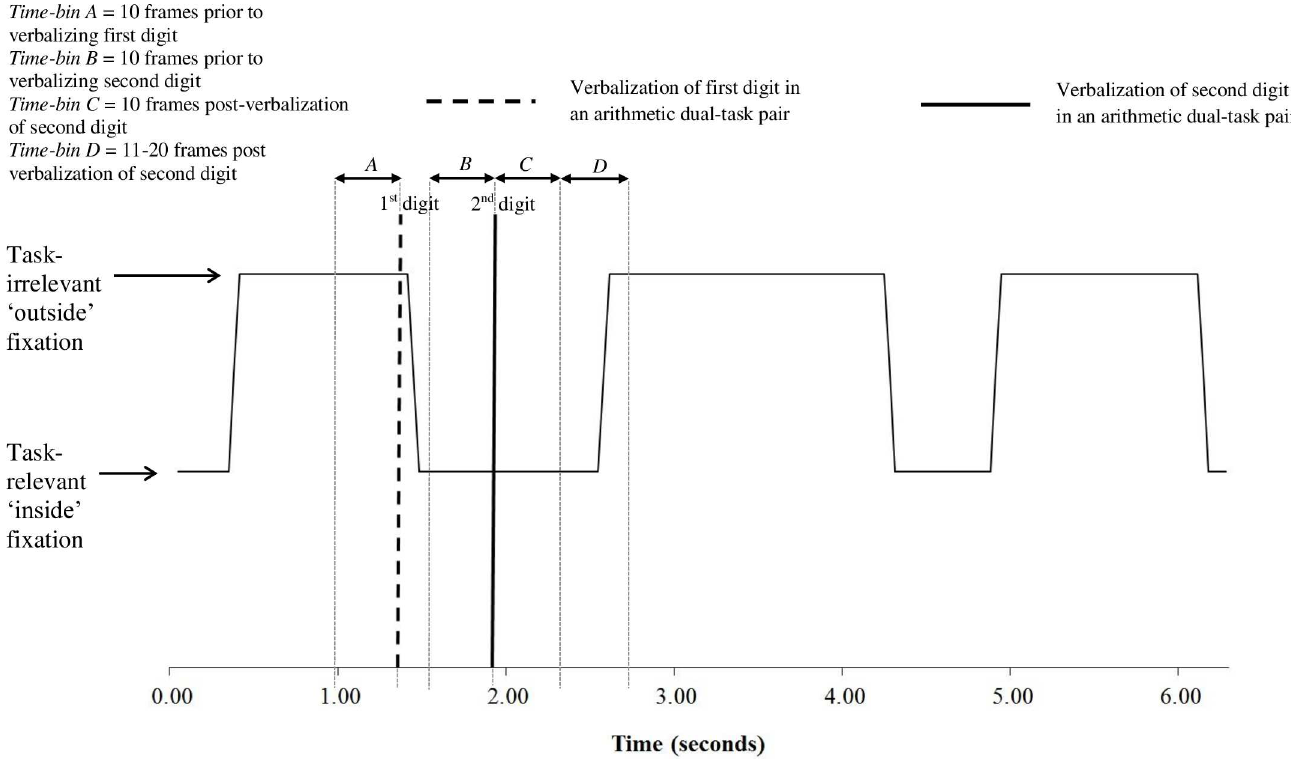
Fig 3. Schematic example of the time-bins utilized to investigate the temporal relationship between cognitive load and visual search.